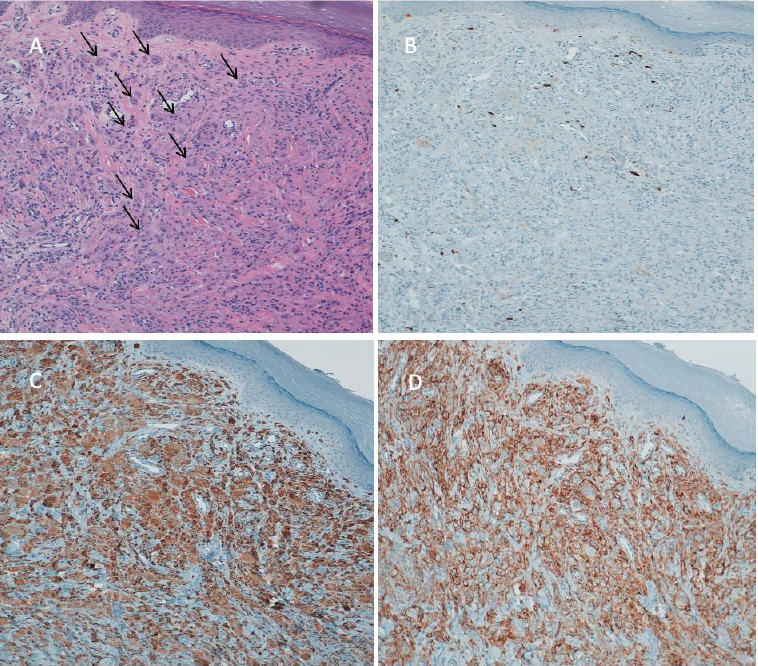
Figure 3. Immunohistological pictures: ( A ) histiocytes and multinucleated giant cells in the dermis indicated by the arrows; ( B ) neurone-specific enolase and Sangtec 100 ( S-100) negative staining for infiltrating cells; ( C ) cluster of differentiation 68 (CD68) and ( D ) cluster of differentiation 45 (CD45) positive cells.